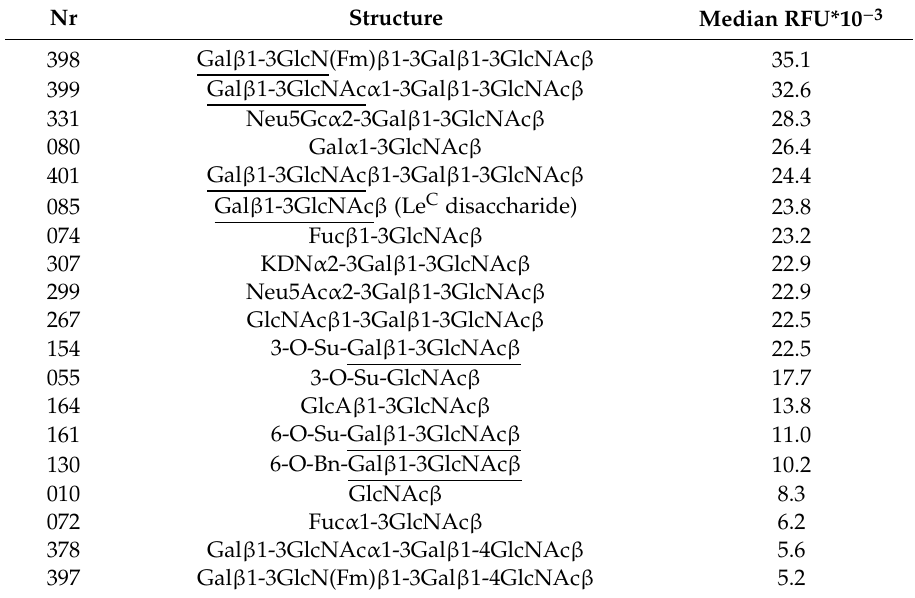
Table 3. Profiling of human antibodies (IgM) isolated from immunoglobulin preparation (CIP) using the Le C -Sepharose a ffi nity adsorbent. Only top-rank glycans are shown. The outmost Le C motifs are underlined; the innermost ones are shown in grey. Only relative fluorescence units (RFU) values > 5000 are shown. Fm, formyl group, that is,